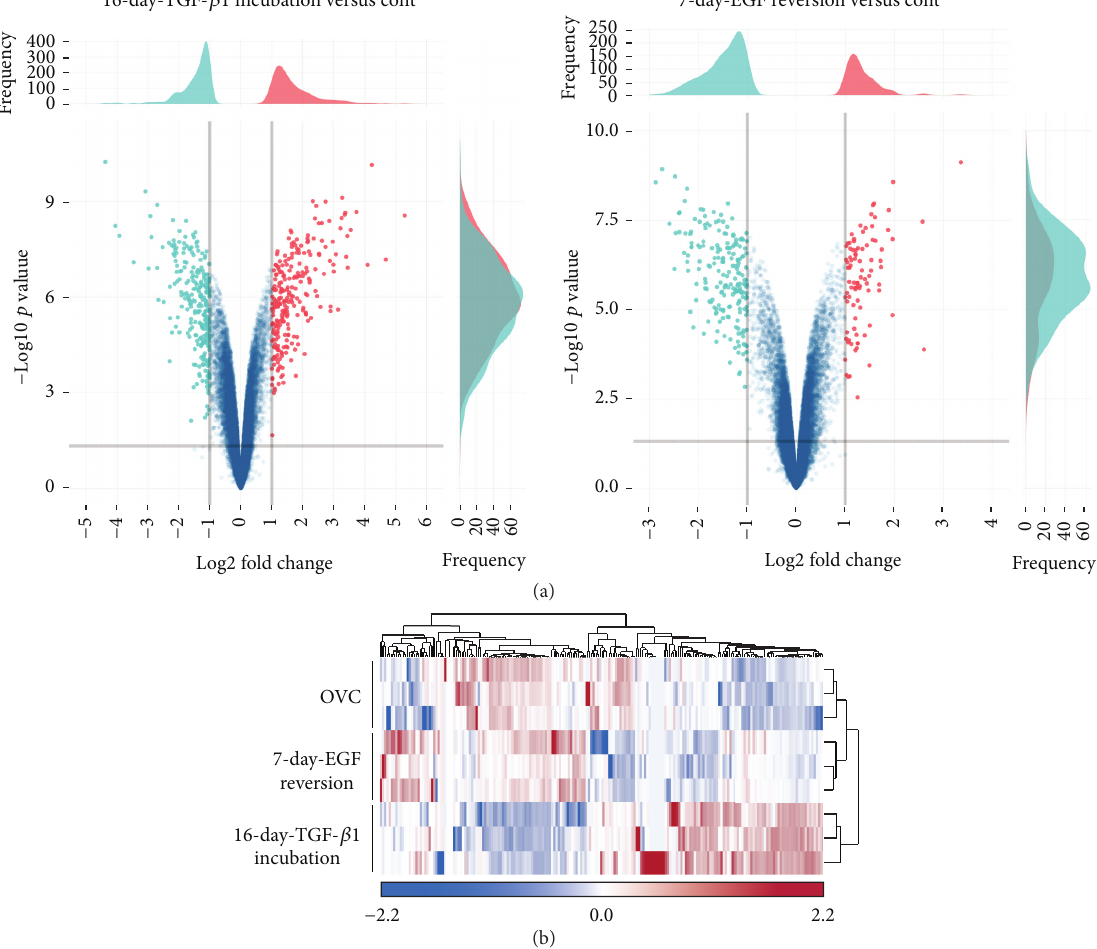
Figure 5: Differential gene expression of hepatic oval cells, 16-day TGF- 𝛽 1 treated cells, and 7-day EGF-reversion cells. (a) Volcano plots contrast significance as the negative logarithm of the 𝑝 value against log2 fold change between 16-day TGF- 𝛽 1 treated versus control and 7- day EGF reversion versus control cells. (b) Hierarchical clustering analysis based on 200 genes significantly differentially expressed between hepatic oval cells, 16-day TGF- 𝛽 1 treated oval cells, and 7-day EGF-reversion oval cells. Scaled expression values were shown for each group with light blue being the lowest and light red as the highest expression level.